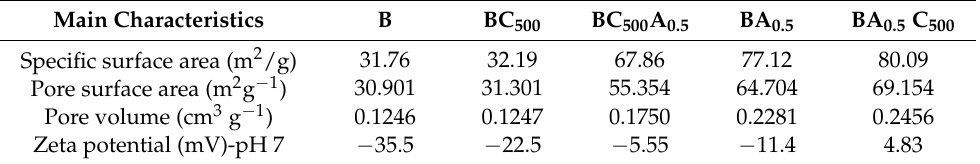
Figure 5. 27 Al MAS NMR spectra for bentonite and modified bentonite ( Spinning side - bands are marked with asterisks ) . Table 4. Surface area, mean pore diameter, and zeta potential of the bentonite and modified ben- tonite